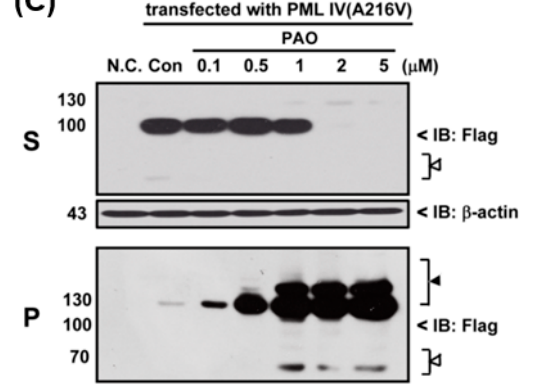
Figure 3. Organic arsenic compound phenylarsine oxide (PAO) is capable of inducing the arsenite-resistant mutant PML (A216V) protein solubility changes. Flag-PML-V transfected 293T cells were exposed to PAO in a concentration-dependent manner (2, 4 and 8 µM) for 1 h ( A ); or in a time-dependent manner (1, 3 and 6 h) at 4 µM ( B ) to determine the PML-V protein solubility changes. Likewise, Flag-PML-IV (A216V) transfected 293T cells were exposed to PAO at indicated concentrations (0.1, 0.5, 1, 2 and 5 µM) ( C ) to determine the protein solubility changes. The star ( ★ ) indicates non-specific protein bands, the white triangle ( △ ) indicates the protein degradation and black triangle ( ▲ ) indicates protein modification. Protein expressions were detected using anti-Flag and anti- β -actin primary antibodies, respectively.